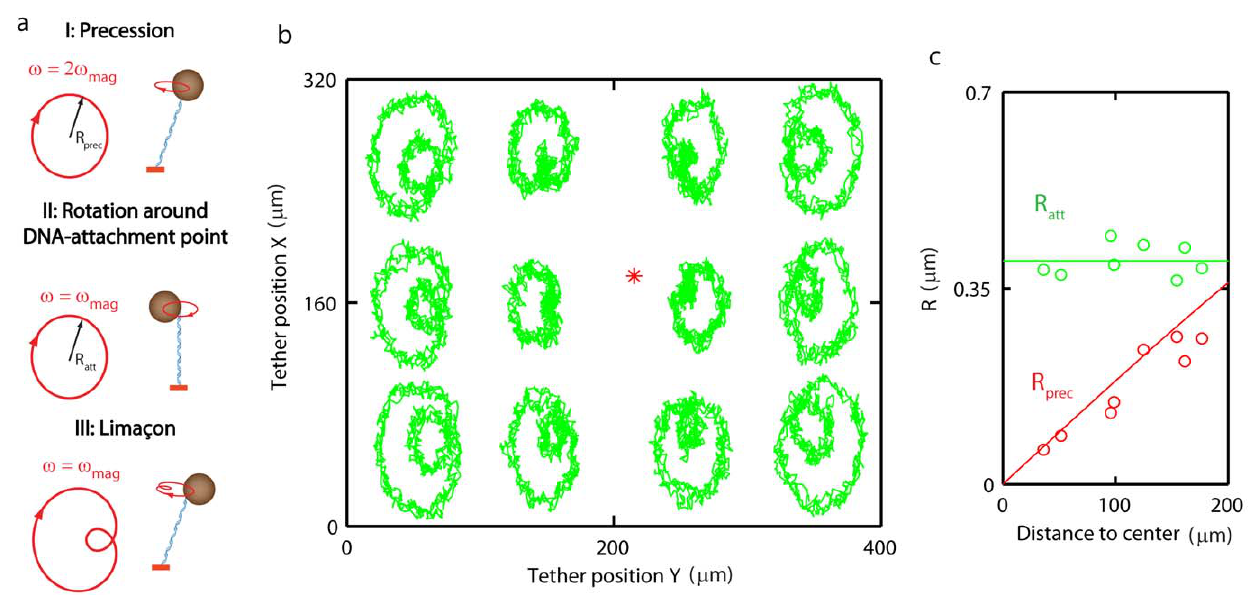
Figure 3. Rotational response of a DNA-bead tether. A The response of a DNA-bead tether subject to a rotating external magnet pair (frequency of rotation v mag ) that is misaligned with respect to the axis of rotation of the magnet pair and for which the DNA attachment position is eccentric, is a combination of a precessional motion with radius, R prec and frequency v =2 v mag (panel I) and a rotational motion around the DNA attachement point with radius, R att and frequency v = v mag (panel II). The bi-circular rotation pattern describes a roulette that is a special case of the epitrochoid: the Limac¸on (panel III). B Measurement of the rotational response for a DNA-bead tether at different positions in the field of view The * denotes the position of the rotation axis of the magnet. For clarity in presentation, the patterns were scaled up by a factor 37.5 compared to the scale of the field of view. C R att and R prec as function of the distance of the tether position to the center of the magnet. R att is independent of the position of the tether in the field of view, as expected. R prec increases with the distance to the center of the magnet. Red line is prediction based on calculations of the 3D force field (as in Fig. 2).